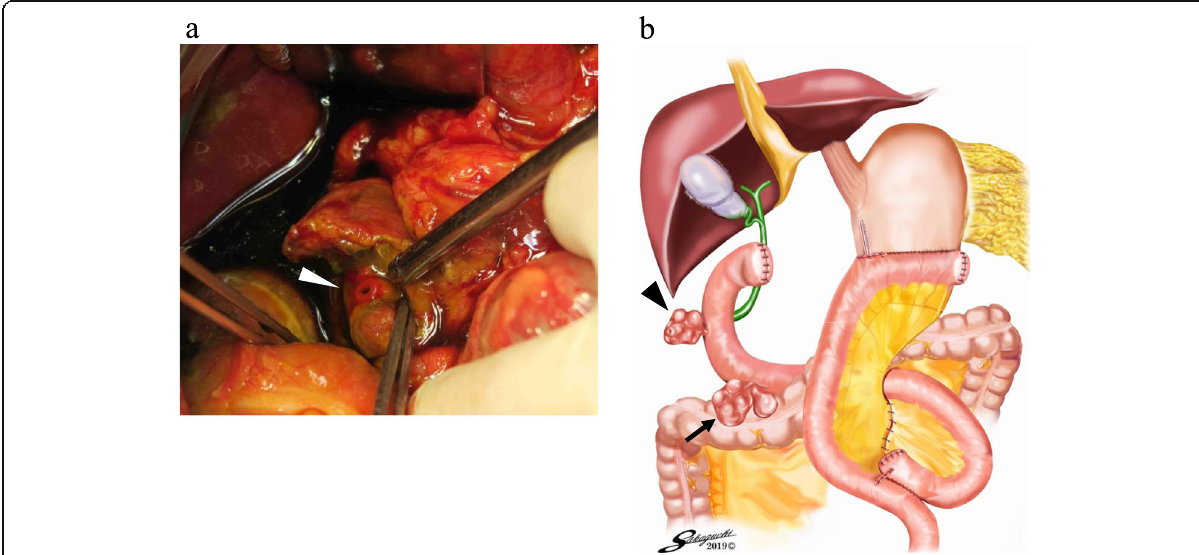
Fig. 4 Surgical findings of case 2. A perforated duodenal diverticulum (white arrowhead) was found at the second part of the duodenum ( a ). The schema showed that a perforated duodenal diverticulum (black arrowhead) was seen at the second part of the duodenum. And the other duodenal diverticulum (black arrow) was detected at the third part of the duodenum, which was not perforated at the time of the emergency operation ( b )